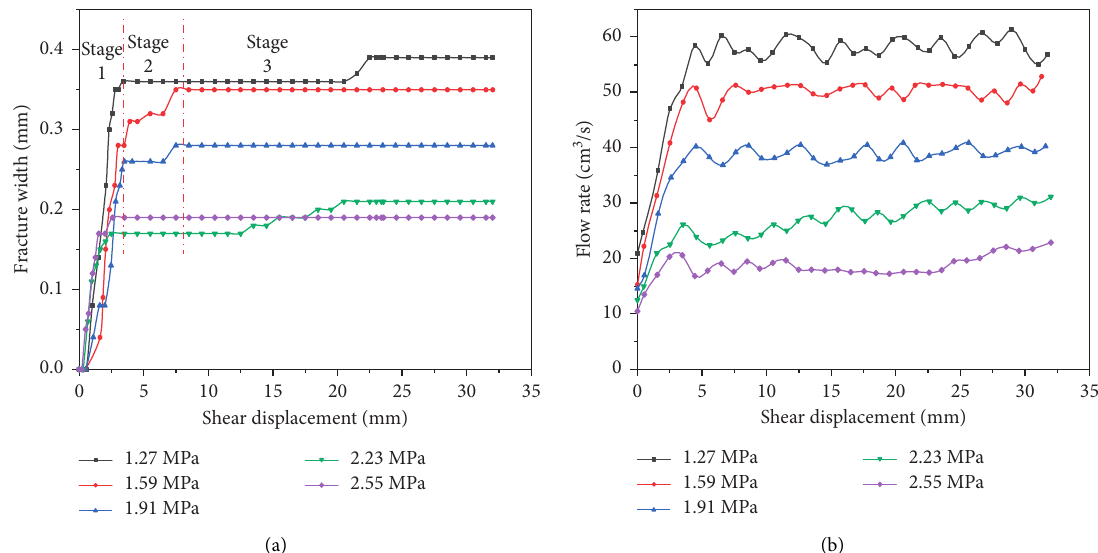
Figure 5: Flow rate and fracture aperture curve under different normal stress